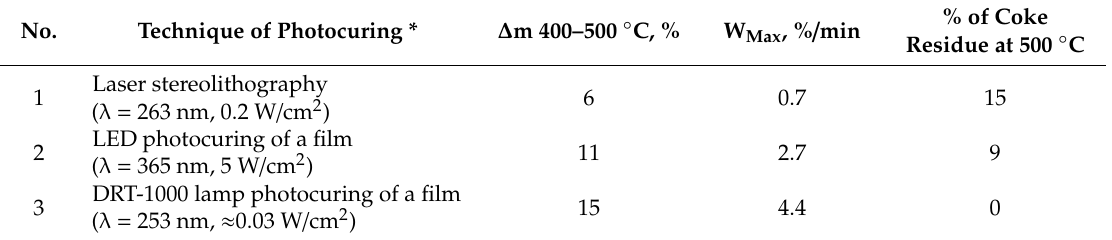
Table 1. The thermooxidative destruction parameters of modified PLA, cured by different techniques.